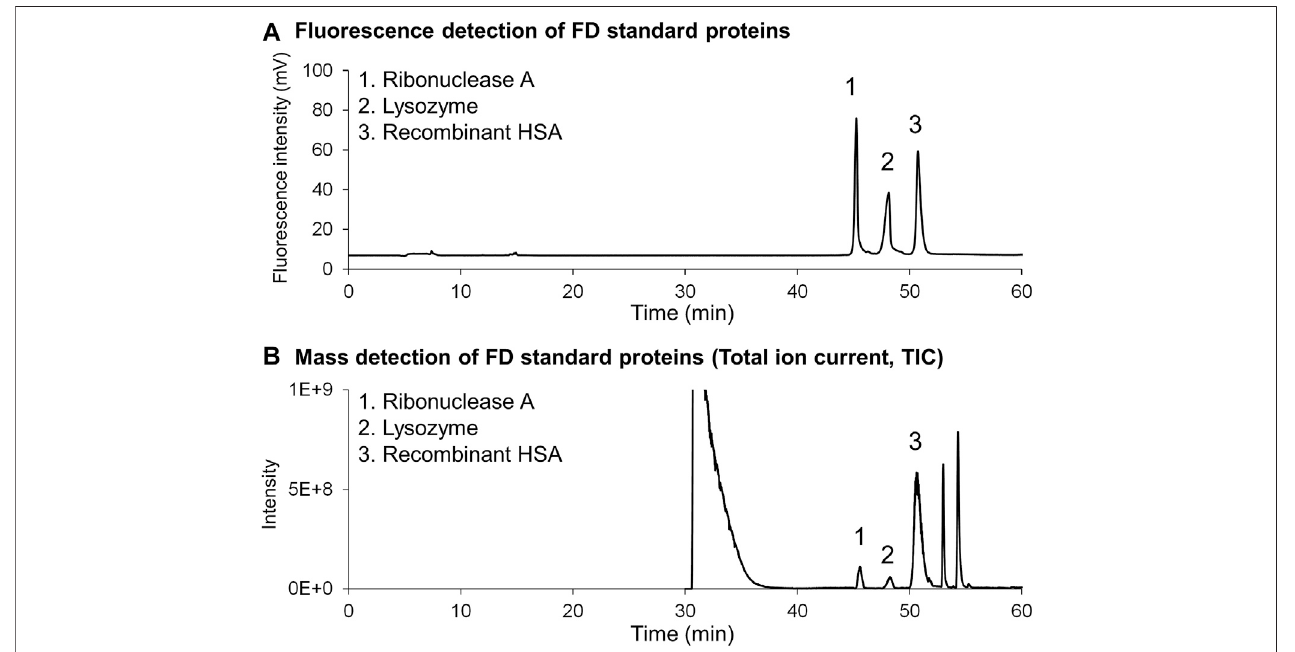
FIGURE 8 | Chromatograms of the (A) fl uorescence detector and (B) mass spectrometer obtained for FD standard proteins dissolved in highly concentrated buffers (6 mol/l guanidine, 10 mmol/l CHAPS, 1 mmol/l EDTA, and 0.5 mmol/l TCEP).